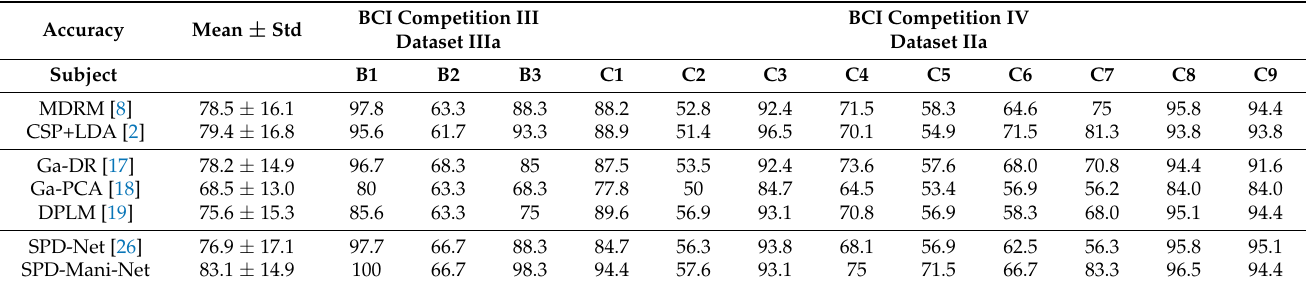
Table 4. Classification accuracies for the EEG datasets from motor image BCIs.